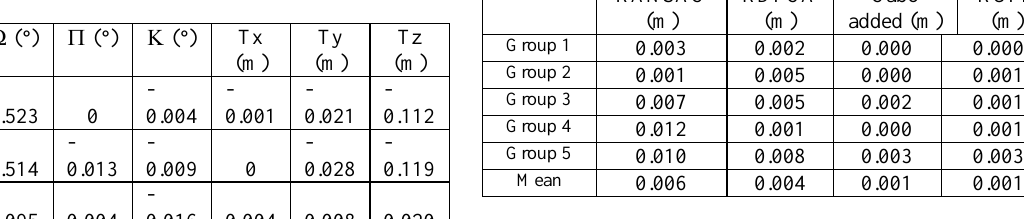
Table 8 Mean error values of each group from three discussed segmentation methods